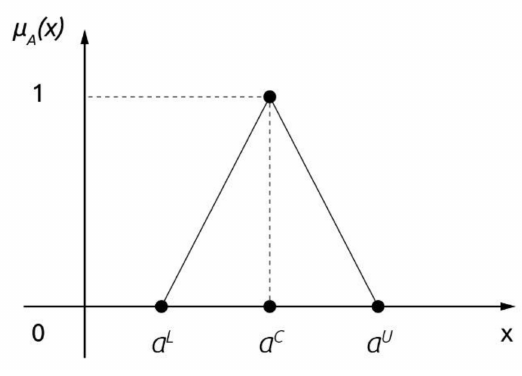
Figure 2. Triangular fuzzy